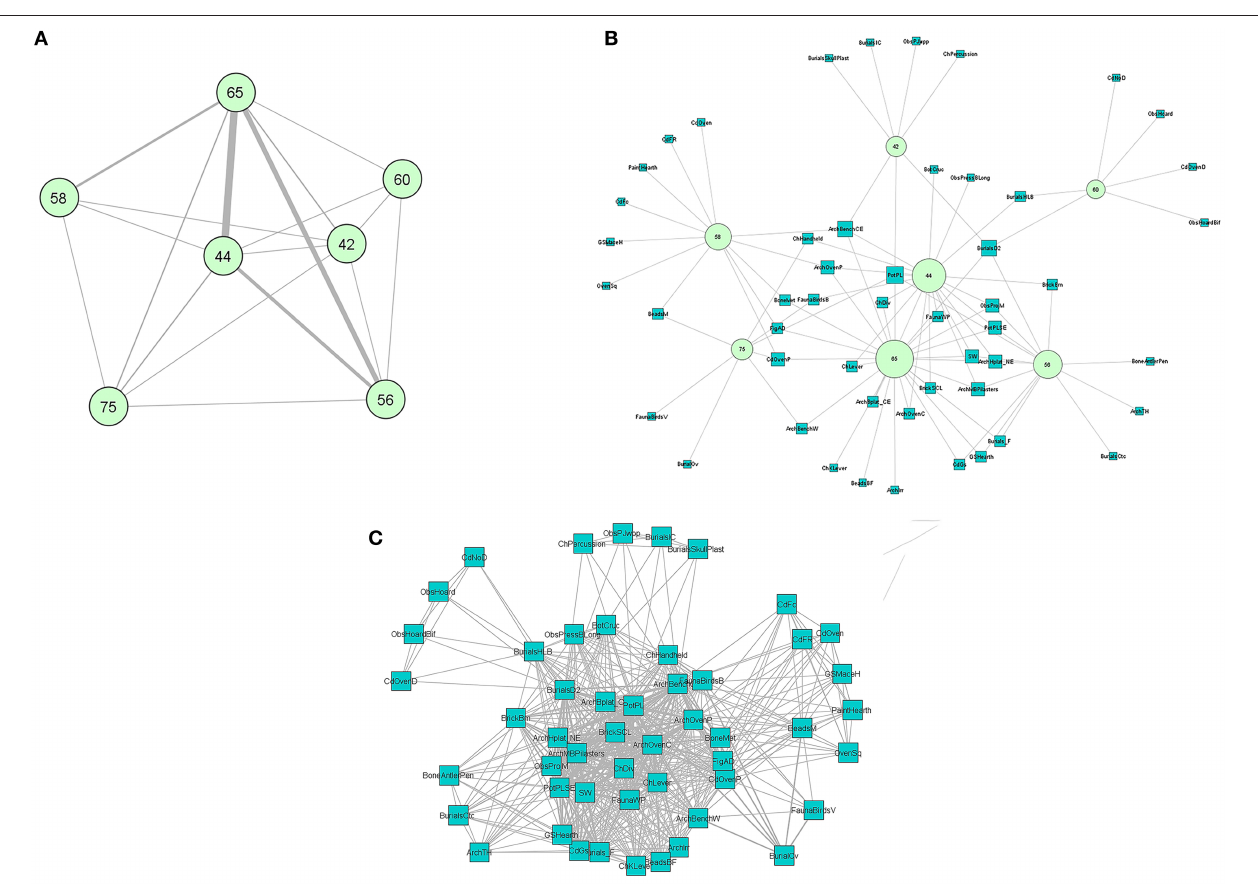
FIGURE 12 | Late network of buildings (A) , 2-mode early network (B) , and early network of objects (C) (The codes used are in the Supplementary Material ).